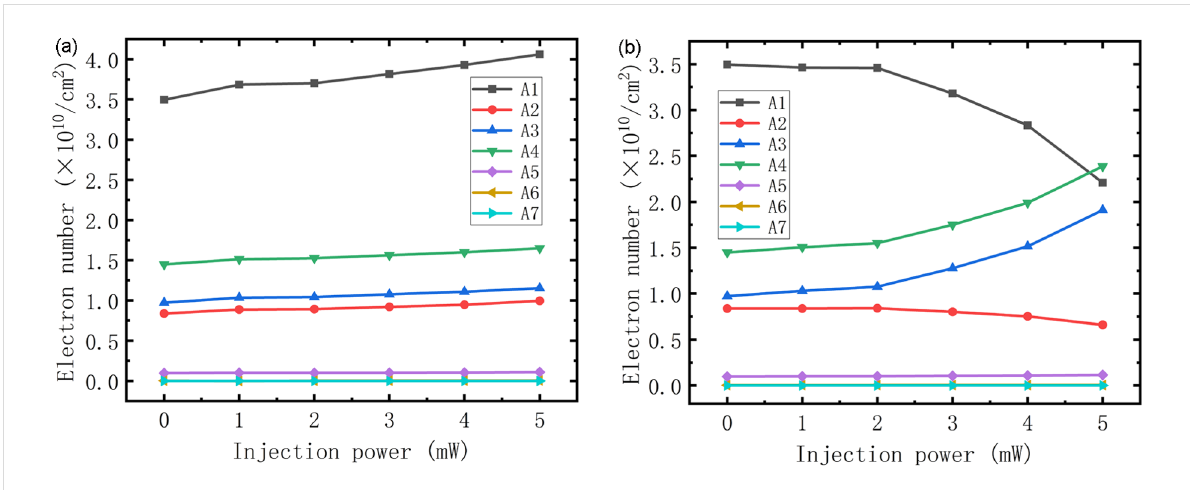
Figure 3: Numbers of electrons in each subband using optical injection at wavelengths of 1550 nm (a) and 820 nm (b).